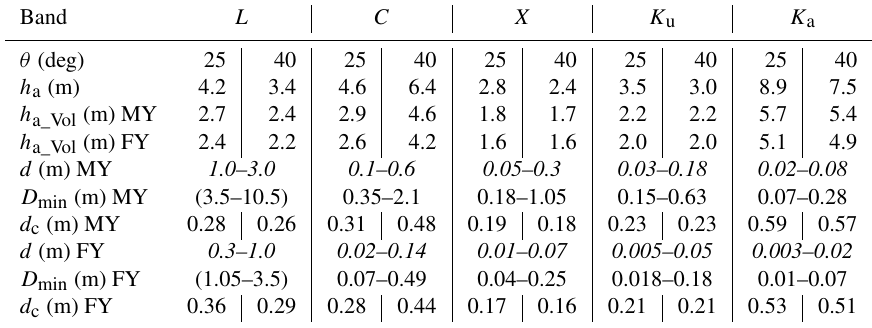
Table 6. Critical penetration limits d c for first-year (FY) and multi-year (MY) ice, determined from Eq. (13) for the satellite constellations shown in Table 1 ( p = 1). For comparison, typical penetration depths d for FY and MY ice are given (see text). For d > d c , the volume correlation is lower than 0.95. Also shown are heights of ambiguity without ( h a ) and with ( h a_Vol ) volume correction according to Eq. (12), together with the minimum ice thickness D min = 3 . 5 d that is required for Eq. (13) to be valid. For L band, Eq. (14) was applied, with D = 0 . 5m for FY and D = 1 . 5m for MY ice ( θ is the incidence